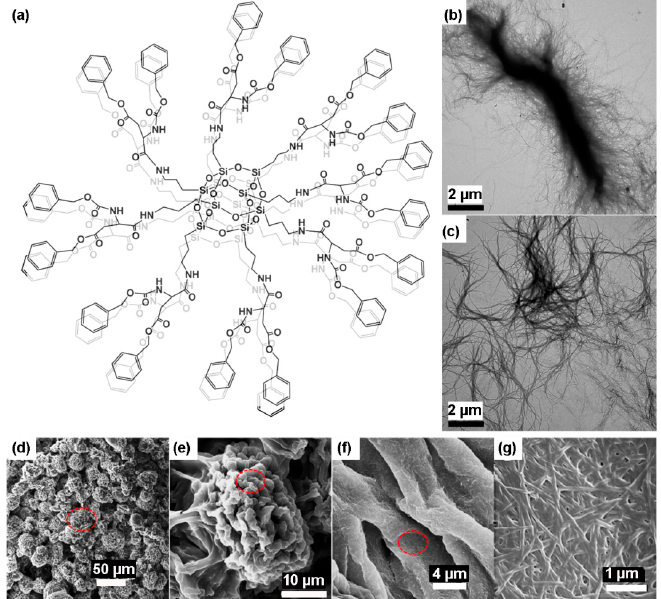
Figure 6. Chemical structure of a polyhedral oligomeric silsesquioxane core-based dendrimer ( a ). Stacking of this planar structure would form a linear structure which grows in the direction out of this paper. TEM ( b , c ) and SEM ( d – g ) images of the xerogel obtained in methyl methacrylate solvent under different magnifications. The red cycles highlight the areas where a higher magnification image was taken. Reproduced from Ref. [90] with permission from the ACS, 2017.